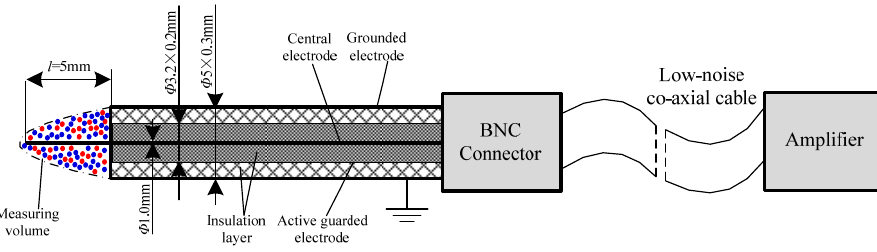
Figure 1. Structure of the capacitance probe measurement system.